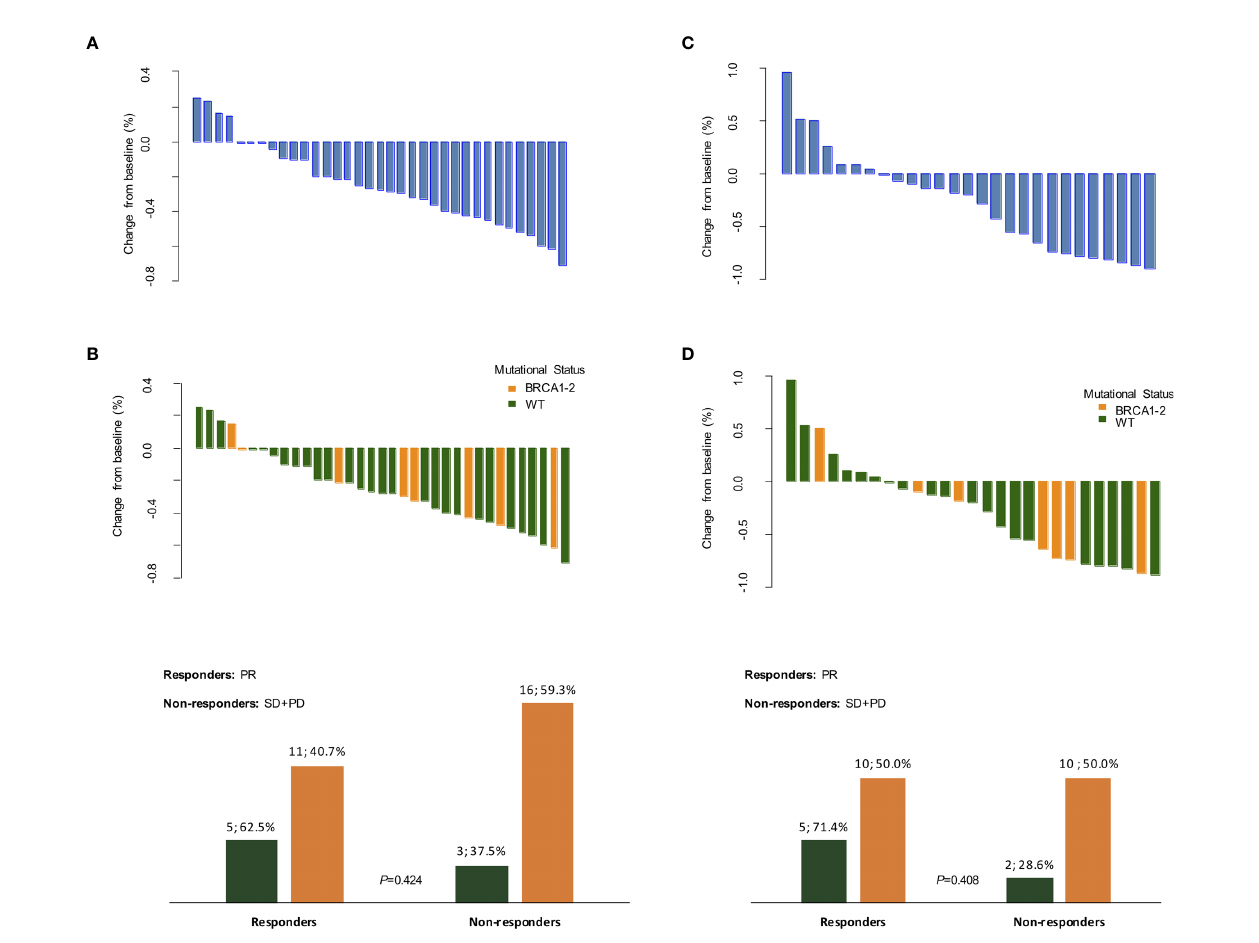
FIGURE 3 | Clinical and radiometabolic responses. Waterfall plots of clinical (A, B) and radiometabolic (C, D) responses in the overall population and according to BRCA mutational status, along with bar plots (B, D) detailing response rates according to BRCA status. PR, partial response; SD, stable disease; PD, progressive disease; WT,